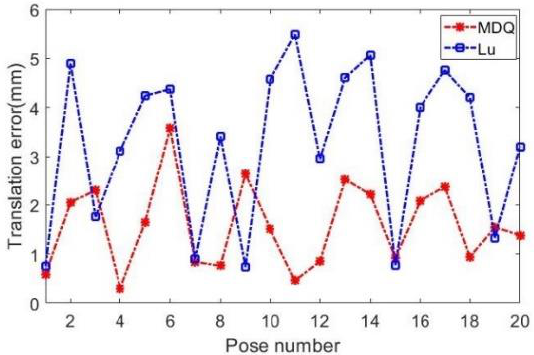
Figure 9. Comparison of the RMS errors in translation of the calibration results.